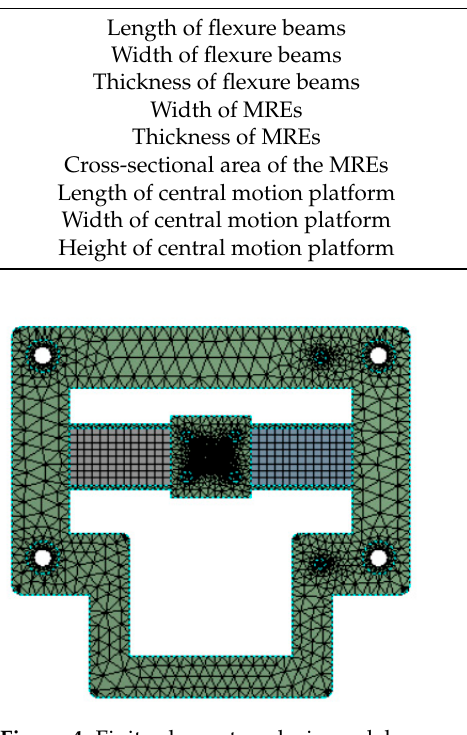
Figure 4. Finite element analysis model. Table 1. Material parameters of the nanopositioner.